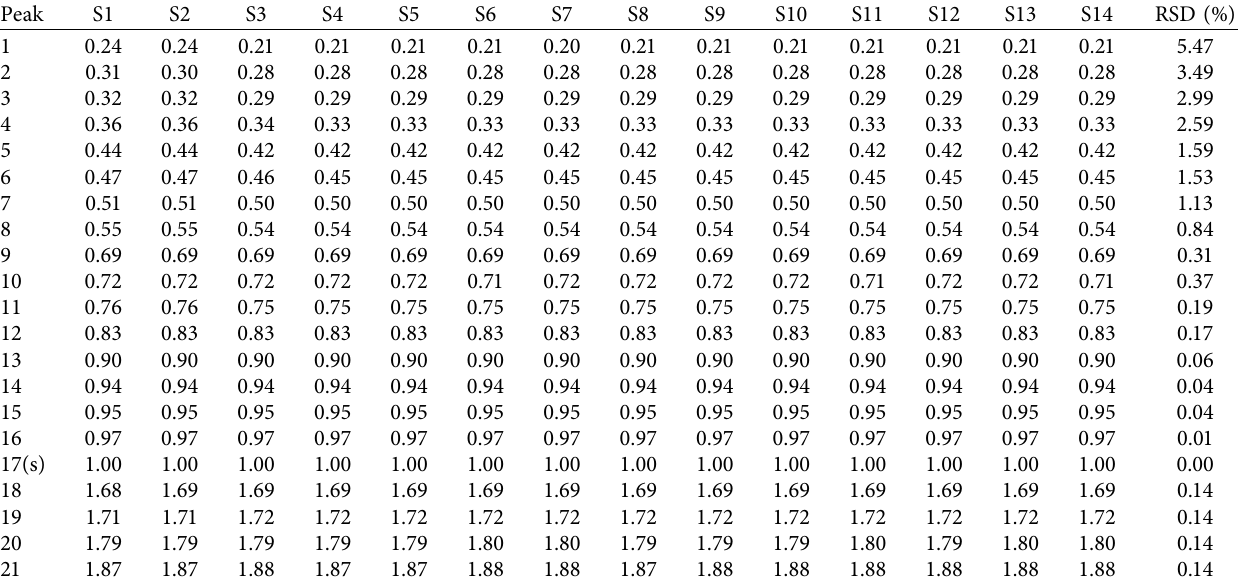
Figure 3: Control fngerprint of CRC leaves (peaks 17, 19, 20, and 21 are hesperidin, nobiletin, tangeretin, and 5-demethylnobiletin). Table 4: Relative retention time of common peaks in fourteen batches of